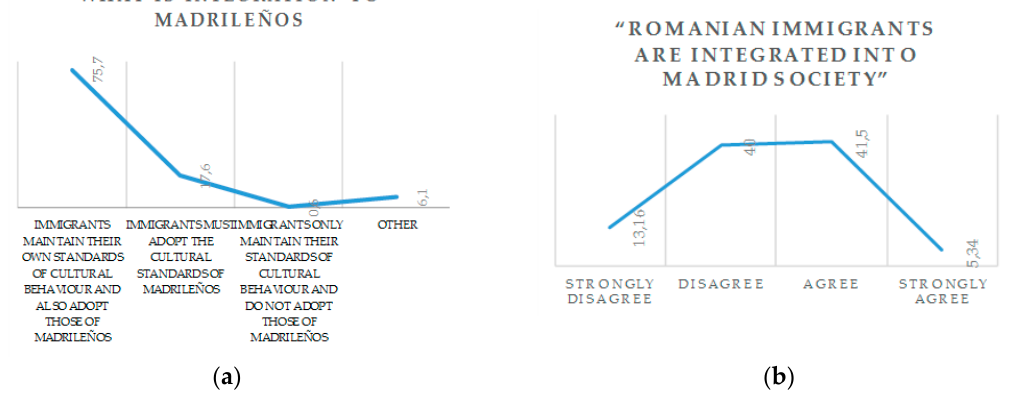
Figure 10. Results from the madrileño informants on issues related to integration. ( a ) Results of the item “What is integration”. ( b ) Results of the item “Romanian immigrants are integrated into Madrid society”.